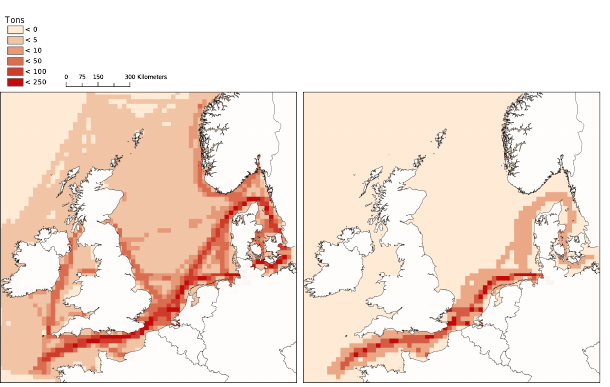
Figure 4. NO x emissions of cargo ships between 5000 and 10000GT (left) and > 100000GT (right).